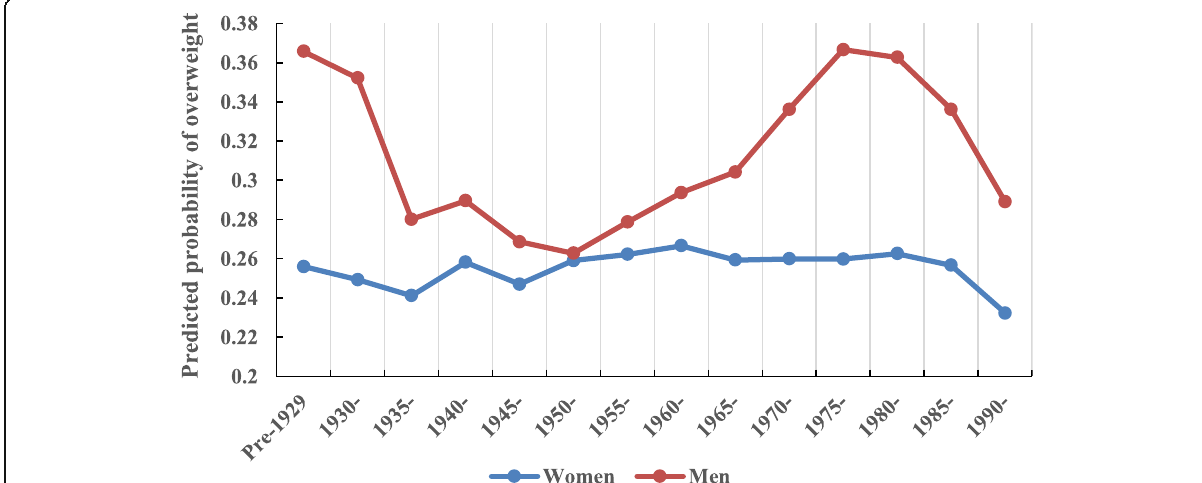
Fig. 2 Gender-specific cohort effects on overweight, adjusted for age and period effects and all